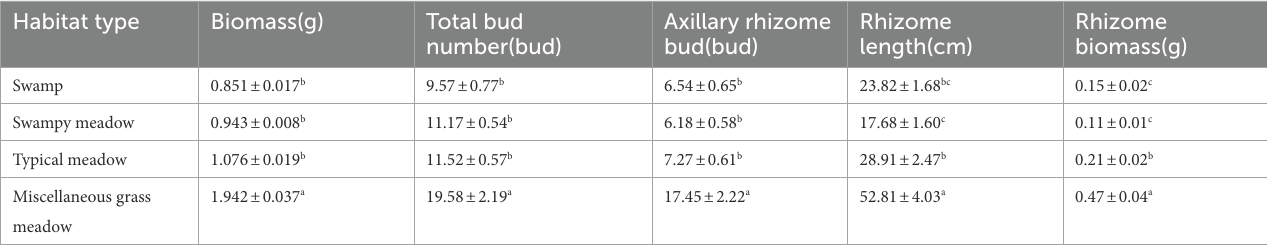
TABLE 3 Characteristics of individual bud of D. angustifolia in four habitats. Habitat